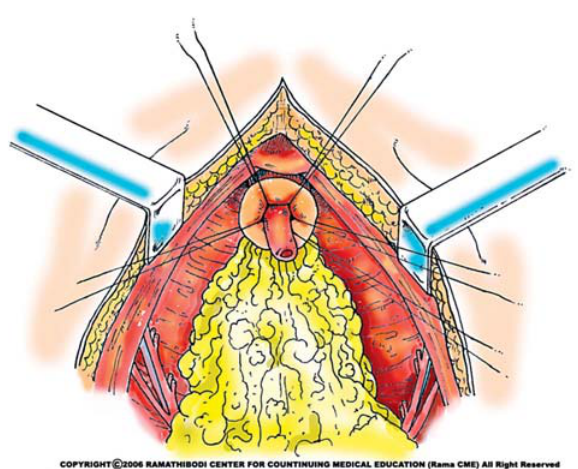
Figure 3 – Omentum is used over sewn with vaginal stump. Dead space of pelvis is obliterated and omentum act as back support for neobladder.